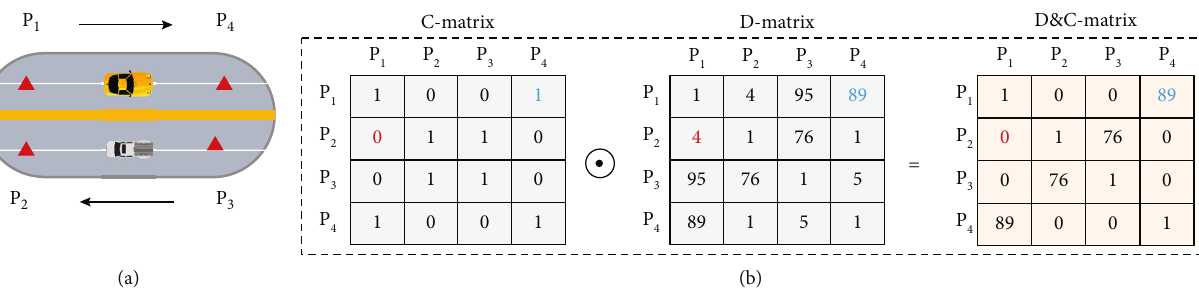
Figure 5: Construction of adjacency matrix. (a) Location distribution of the four toll-gates (Yellow lines represent dividing fences that vehicles on the freeway cannot pass through). (b) The process of building an adjacency